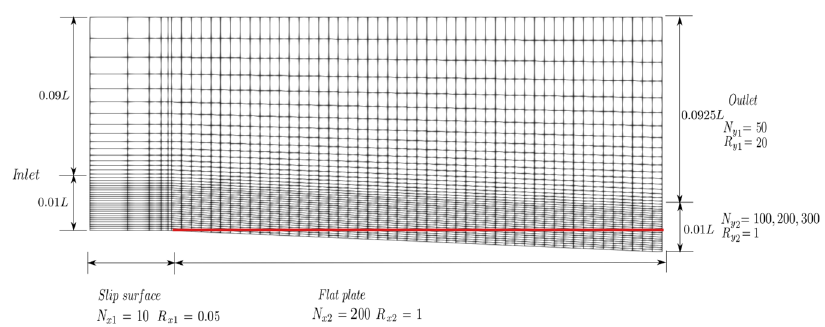
Figure 5. Sketch of the rotated (stretched) mesh for turbulence flow over a flat plate.